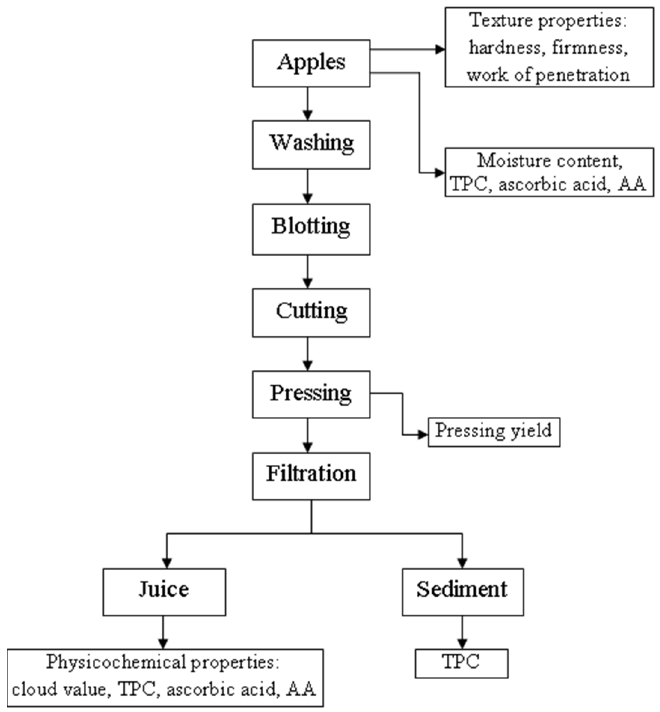
Figure 1. Experimental flowchart.